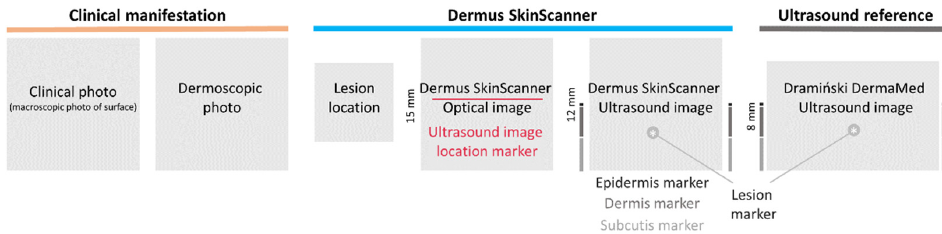
Figure 2. The layout in which the results of examinations are presented in this article. On the left, photo-documentation of the visual information seen by a dermatologist on a basic examination is presented: clinical (macroscopic) and dermoscopic photo of the lesion. Image information provided by the Dermus SkinScanner device is presented on the middle: lesion location (as marked by the investigator, on a body schematic), optical image with a red line marker representing the location of the corresponding ultrasound image slice, and the corresponding ultrasound image. The ultrasound image of the reference device is presented on the right. The primary skin layers and the lesion itself are marked on both ultrasound images as an aid for the interpretation of the images. Scaling of the images is also presented in this figure for reference (the aspect ratio is 1:1 for all of the images). The lesion markers (white stars) are placed just above the investigated lesion.